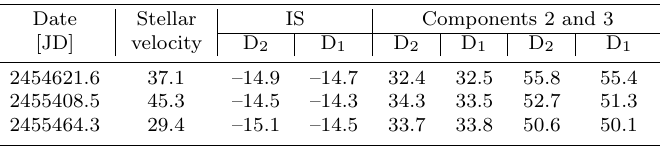
Table 3. Heliocentric velocities (in km s − 1 ) of the Na I D-line components in the spectrum of R Sct. Date Stellar